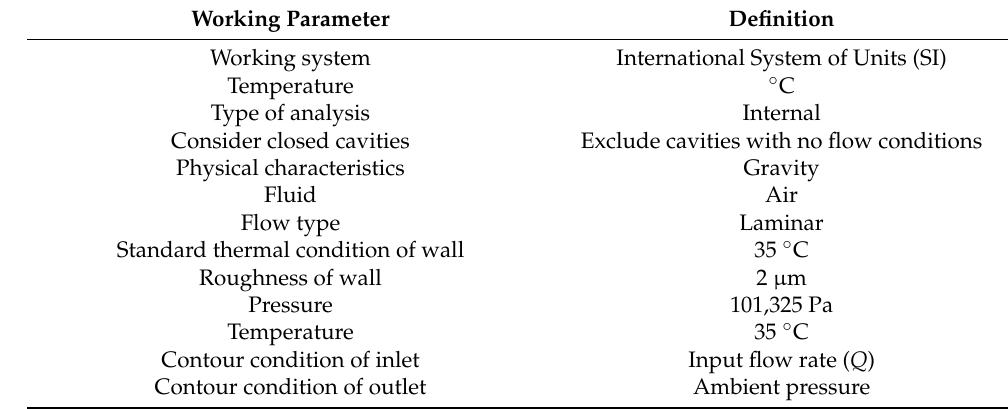
Table 6. Operating parameters used in